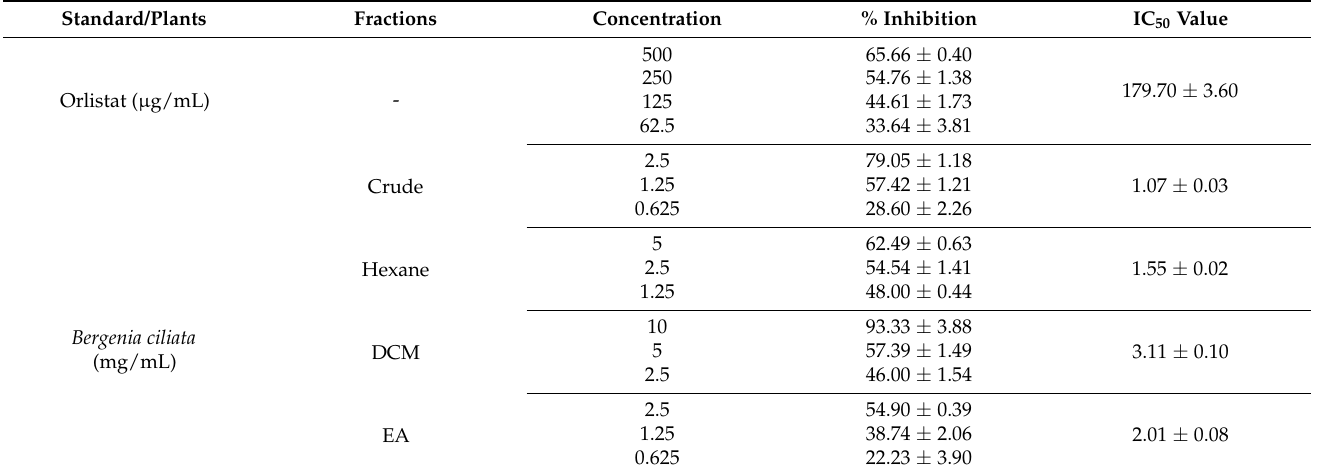
Table 2. Lipase inhibition at different concentrations of medicinal plants and their IC 50